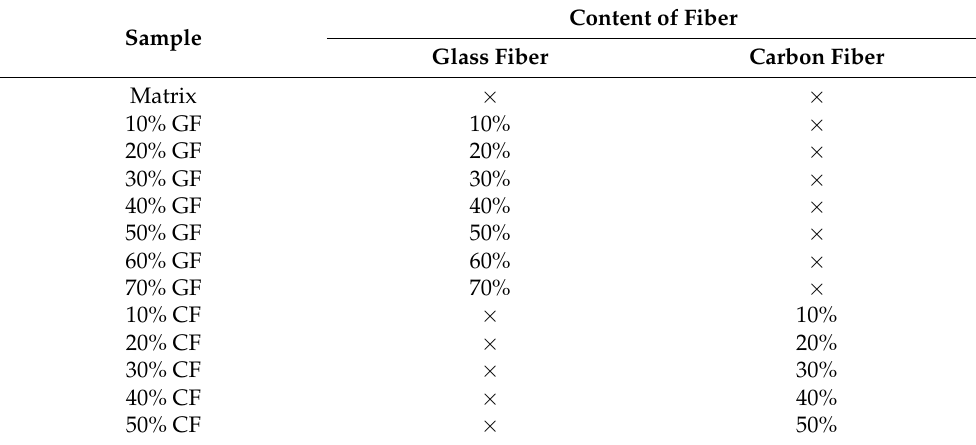
Table 1. Composition of